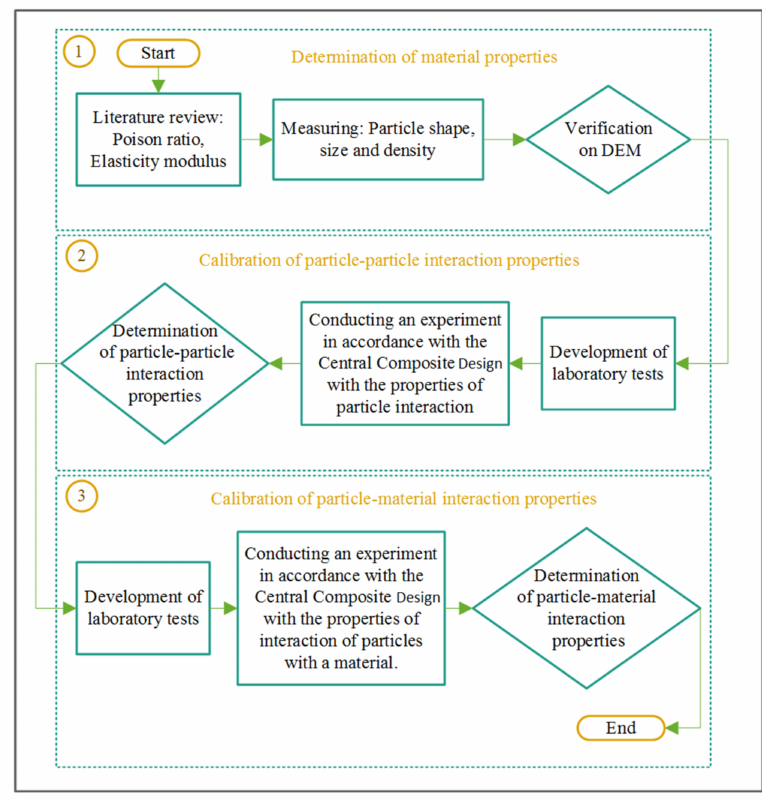
Figure 1. Strategy to calibrate interaction